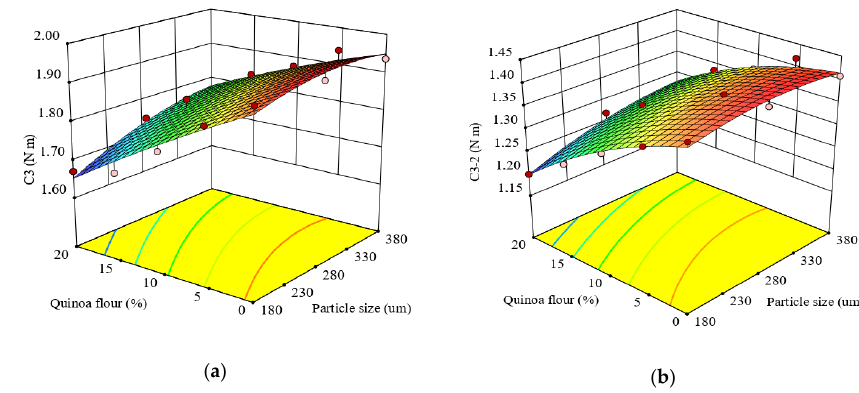
Figure 3. Response surface graph for combined effects of quinoa flour particle size and level added in refined wheat flour on Mixolab parameters during starch gelatinization stage: ( a ) C3 torque (C3) and ( b ) difference between torques C3 and C2 (C3–2).